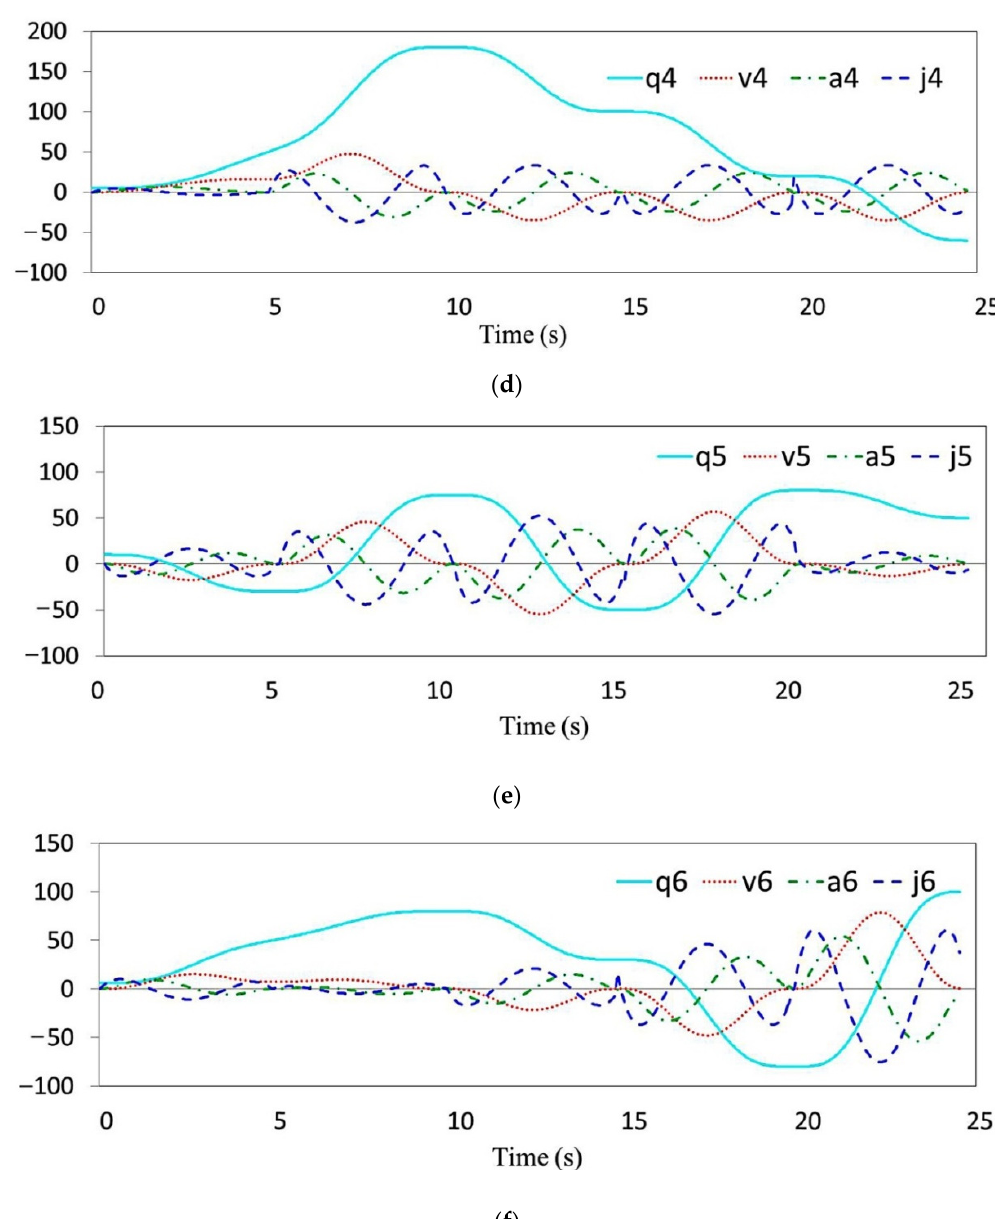
Figure 4. Movements of joints after optimization based on the SMWOA. ( a ) Movement of base joint θ 1 ; ( b ) Movement of shoulder joint θ 2 ; ( c ) Movement of elbow joint θ 3 ; ( d ) Movement of wrist joint θ 4 ; ( e ) Movement of wrist joint θ 5 ; ( f ) Movement of wrist joint θ 6 .